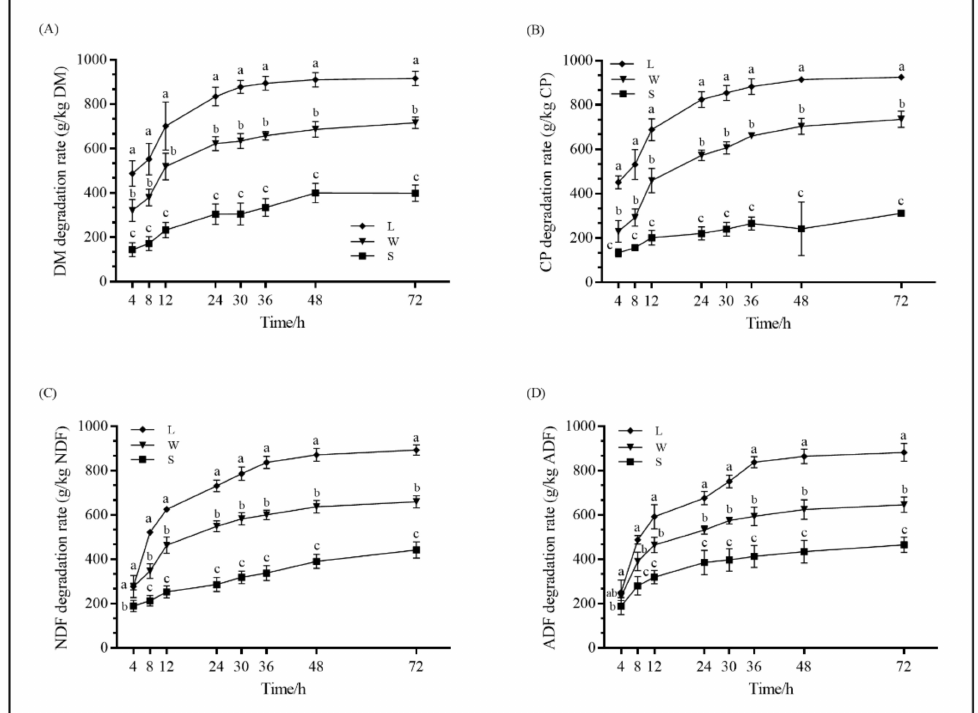
Figure 1. The real-time degradation rates of different parts of PM silage in rumen ( A ), DM, ( B ) CP, ( C ) NDF, and ( D ) ADF. Means within the same time point with different letters are significantly different ( p < 0.05). L: leaf; S: stem; W: whole plant; DM: dry matter; CP: crude protein; NDF: neutral detergent fiber; ADF: acid detergent